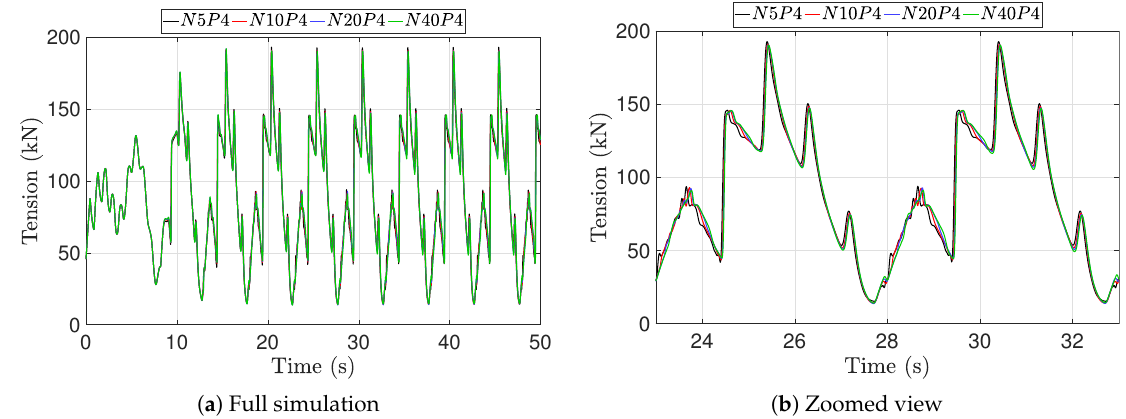
Figure A1. Tension at the upper tether node for different mesh resolutions. The fairlead motion was a prescribed circular orbit of a = 2 m radius at 0.2